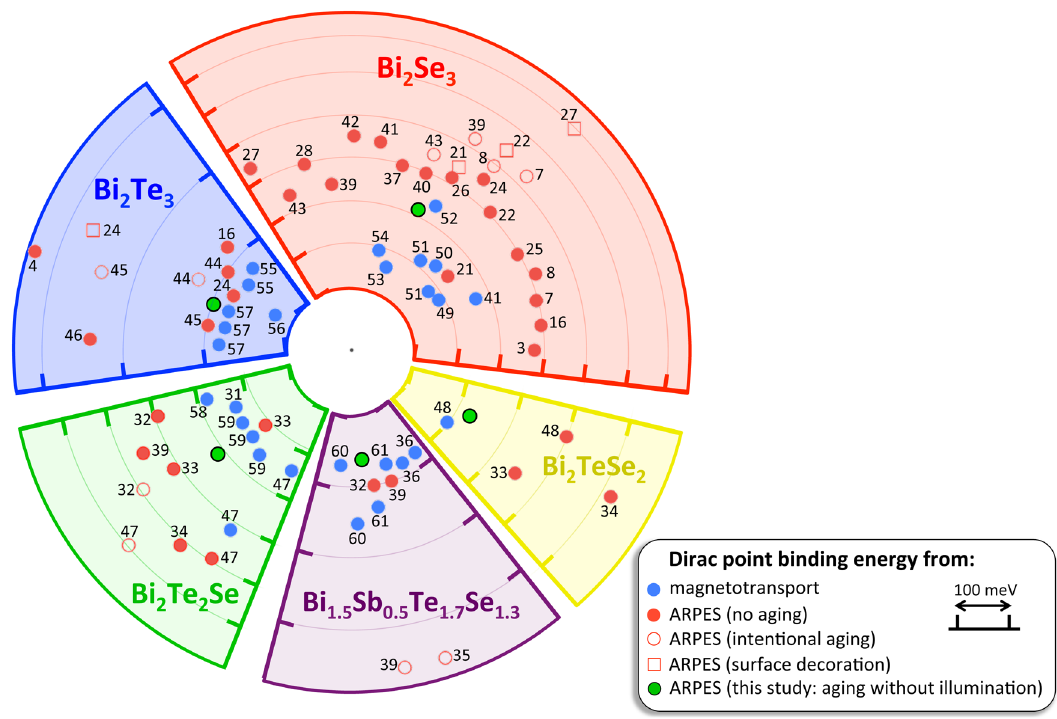
FIG. 1. Discrepancies between the experimentally determined Dirac point energies for TI surface states between ARPES and quantum oscillations. The graphic shows the binding energy of the Dirac point ( E D ) in five different 3D topological insulator materials as extracted from published transport (blue symbols) and ARPES (red symbols) studies. The border of the inner circle corresponds to zero binding energy of the Dirac point (i.e., E D ¼ E F ). The binding energy increases radially with each tick denoting an increase of 100 meV. Notice the different axes scale for each compound. Filled circles denote data from samples which have not been intentionally aged in UHV, and measurements have been typically performed within an hour of sample cleavage. Empty squares and circles denote that air exposure and intentional aging under UHV conditions have been carried out, respectively. Green circles show the value of E D extracted from ARPES data presented in this study: these surfaces have been intentionally exposed to UHV residual gases for 3 h, but their total exposure to external illumination was of only a single second. The green data points are taken from the ARPES data presented in Figs. 2 and 3 for each compound, whereby we note a slight variation in the composition of the Bi 2 − x Sb x Te 3 − y Se y used (i.e., x ¼ 0 . 54 instead of 0.5), and that the green ARPES data point in the Bi 2 TeSe 2 panel is from the related system BiSbTeSe 2 . The number next to each red and blue marker is the literature reference from which E D is